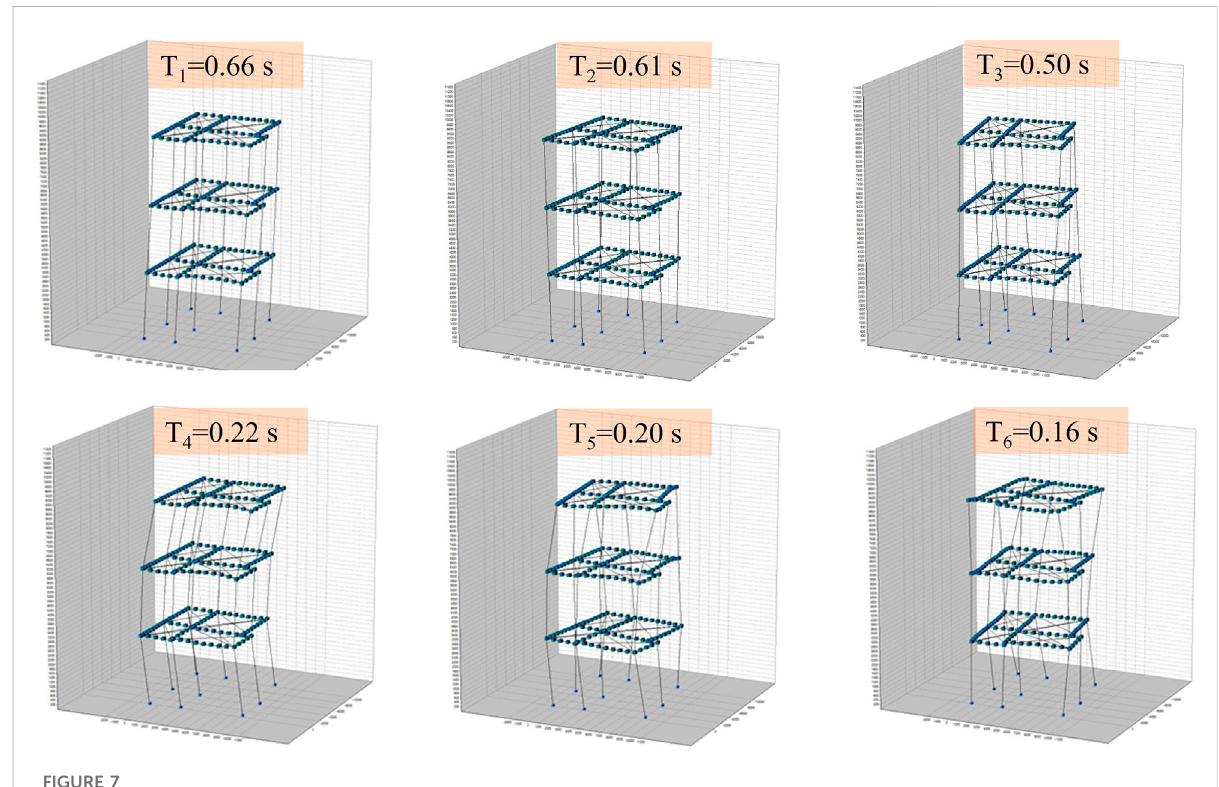
FIGURE 7 Modal response of the SPEAR building.